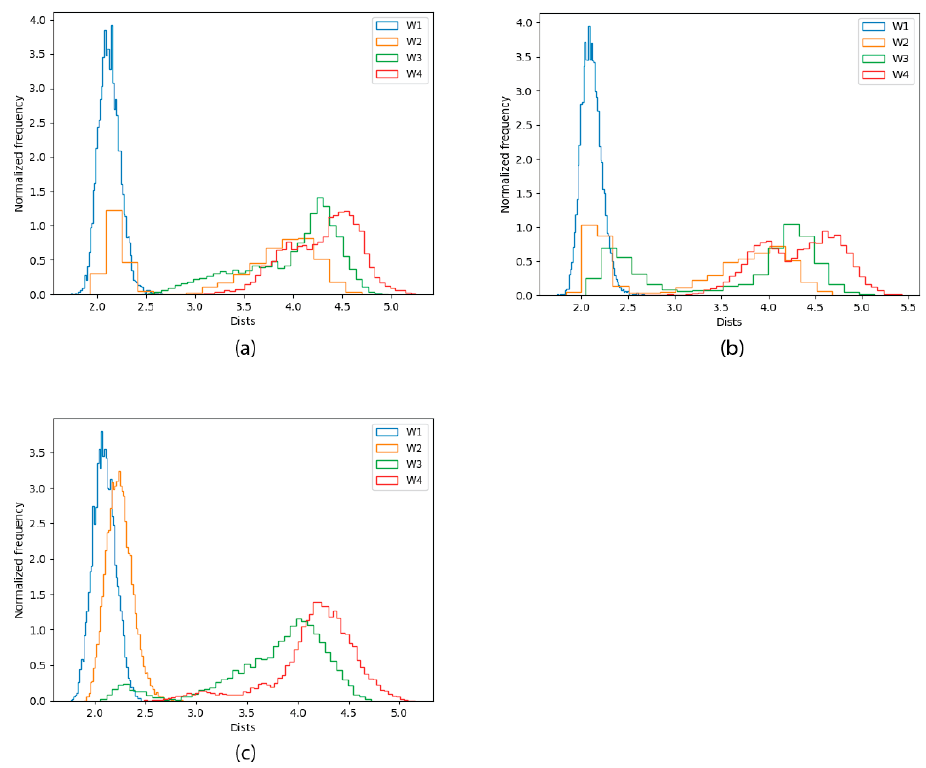
Figure 5. Frequency histograms for the distances of the four closest water molecules to the Zn(II) ion (named starting from the closest, W1 through W4), and the metal in the 30 ps QM/MM MD simulations. ( a ) WT trajectories; ( b ) C132A trajectories; ( c ) C132A/C159A trajectories.